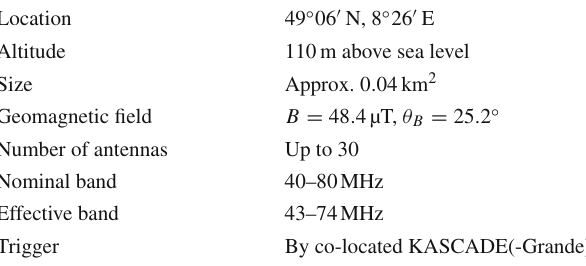
Table 1 Properties of the LOPES